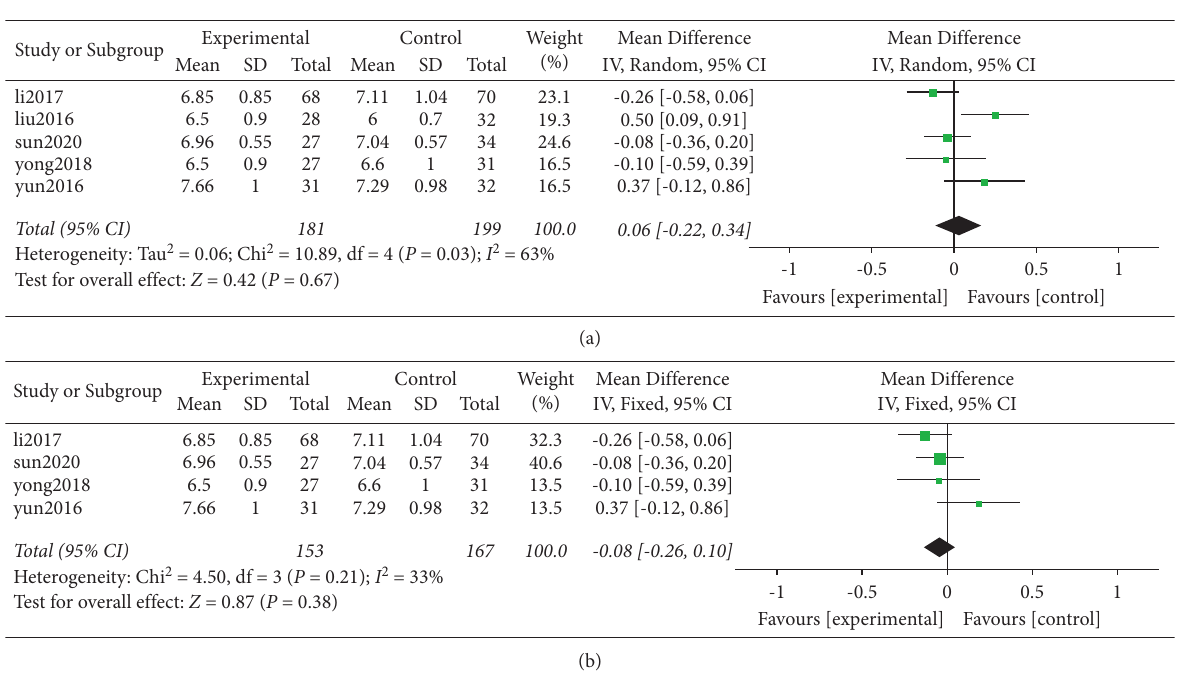
Figure 7: (a) Postoperative DHI and (b) sensitivity analysis on postoperative